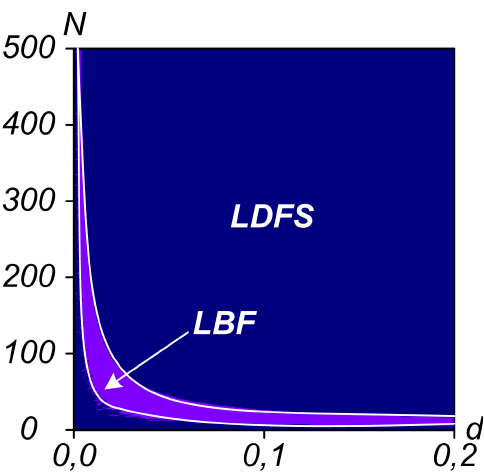
Figure 5: Comparison of methods LBF and LDFS decisions quality by the criterion of the probability of obtaining a better decision.